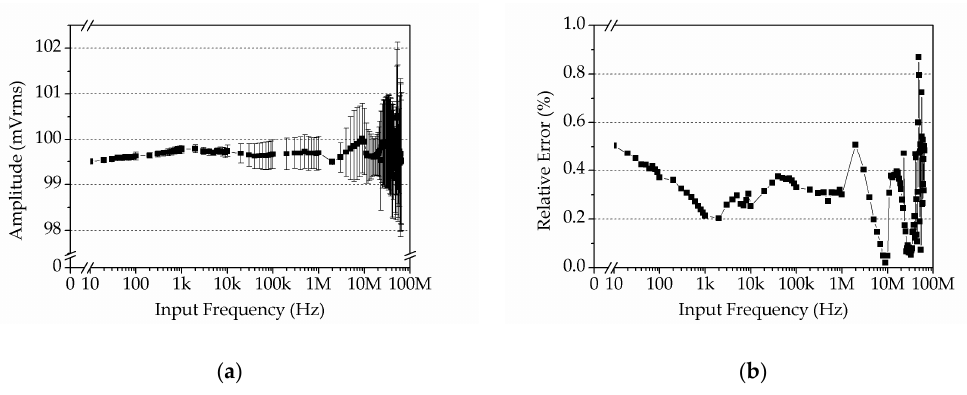
Figure 12. Measurement results. ( a ) Amplitude–frequency response of the DLIA. ( b ) Relative error of measurement results was less than 0.9%. The sharp change of the relative error when input frequency exceeded 10 MHz was because the parasitic effect became much effective.